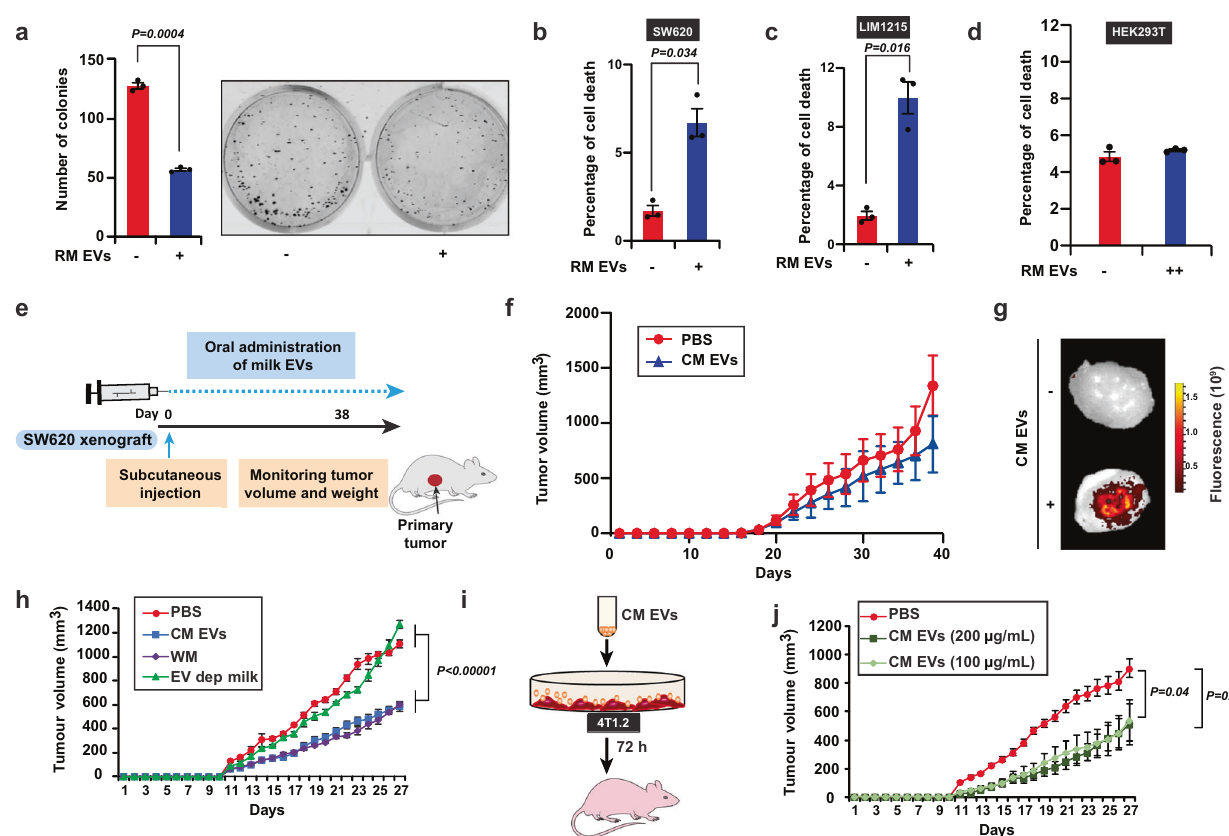
Fig. 3 Milk-derived EVs reduce tumor burden. a SW620 colorectal cancer cells were treated with RM EVs (20 μ g/mL) and colonies were quanti fi ed ( n = 3). b Apoptosis of SW620 colorectal cancer cells at 72 h after treatment with RM EVs (20 μ g/mL; n = 3). c Apoptosis of LIM1215 colorectal cancer cells at 72 h after treatment with RM EVs (20 μ g/mL; n = 3). d Apoptosis of human embryonic kidney (HEK293) cells at 72 h after treatment with RM EVs ( ++ = 50 μ g/mL; n = 3). e Schematic representation of colorectal cancer xenograft experiment. f Tumor volume of SW620 xenografts measured after oral administration of PBS and CM EVs (25 mg/kg; n = 3). g SW620 tumor-bearing mice were orally administered with a single dose of DiR-labeled EVs (25 mg/kg). IVIS imaging of the harvested tumor tissue after 24 h of EVs administration is displayed. h Tumor volume of 4T1.2 bearing mice after oral administration of PBS, CM EVs (25 mg/kg), WM (70 µ L), and EV-depleted milk ( n = 5). i 4T1.2 cells were treated with CM EVs (100 and 200 µ g/mL) for 72 h and injected into Balb/c mice. j Tumor volume of 4T1.2 cells treated with and without CM EVs ( n = 5). All data are represented as mean ± s.e.m. Statistical signi fi cance was determined by unpaired two-tailed t